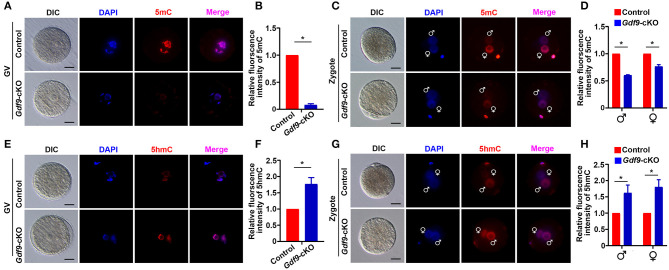
Maternal UHRF1 depletion causes DNA hypomethylation at oocytes and zygotes. (A) The representative immunofluorescent-staining images for anti-5-methylcytosine (anti-5-mC) of control and Gdf9-cKO GV oocytes are shown. Nuclei were stained with DAPI. Scale bar = 50 μm. (B) Histogram shows a semi-quantitative analysis regarding changes of 5-mC distribution of fluorescence intensity at GV oocytes of (A). Quantification of the level of 5-mC in control and Gdf9-cKO oocytes and data are presented as means ± SEM from three independent experiments (total number of GV oocytes analyzed: n = 92 for control, n = 81 for Gdf9-cKO). *p < 0.05. (C) Representative immunofluorescent-staining images for 5-mC of control and Gdf9-cKO zygotes are shown. Nuclei were stained with DAPI. Scale bar = 10 μm. (D) Histogram shows a semi-quantitative analysis of changes in the fluorescence intensity, indicating the 5-mC distribution in zygotes of (C). Data are presented as mean ± SEM. n = 3 independent experiments (total number of zygotes analyzed: n = 131 for control, n = 73 for Gdf9-cKO). *p < 0.05. (E,F) Representative immunofluorescent staining images (E) and the quantification of fluorescence intensity (F) for 5-hydroxymethylcytosine (5-hmC) of control and Gdf9-cKO GV oocytes are shown. Data are presented as mean ± SEM. n = 3 independent experiments (total number of GV oocytes analyzed: n = 121 for control, n = 87 for Gdf9-cKO). (G,H) Representative immunofluorescent-staining images (G) and fluorescence intensity quantification (H) for 5-hmC of control and Gdf9-cKO zygotes are shown. Data are presented as mean ± SEM. n = 3 independent experiments (total number of zygotes analyzed: n = 95 for control, n = 78 for Gdf9-cKO). Scale bar = 50 μm. *p < 0.05.